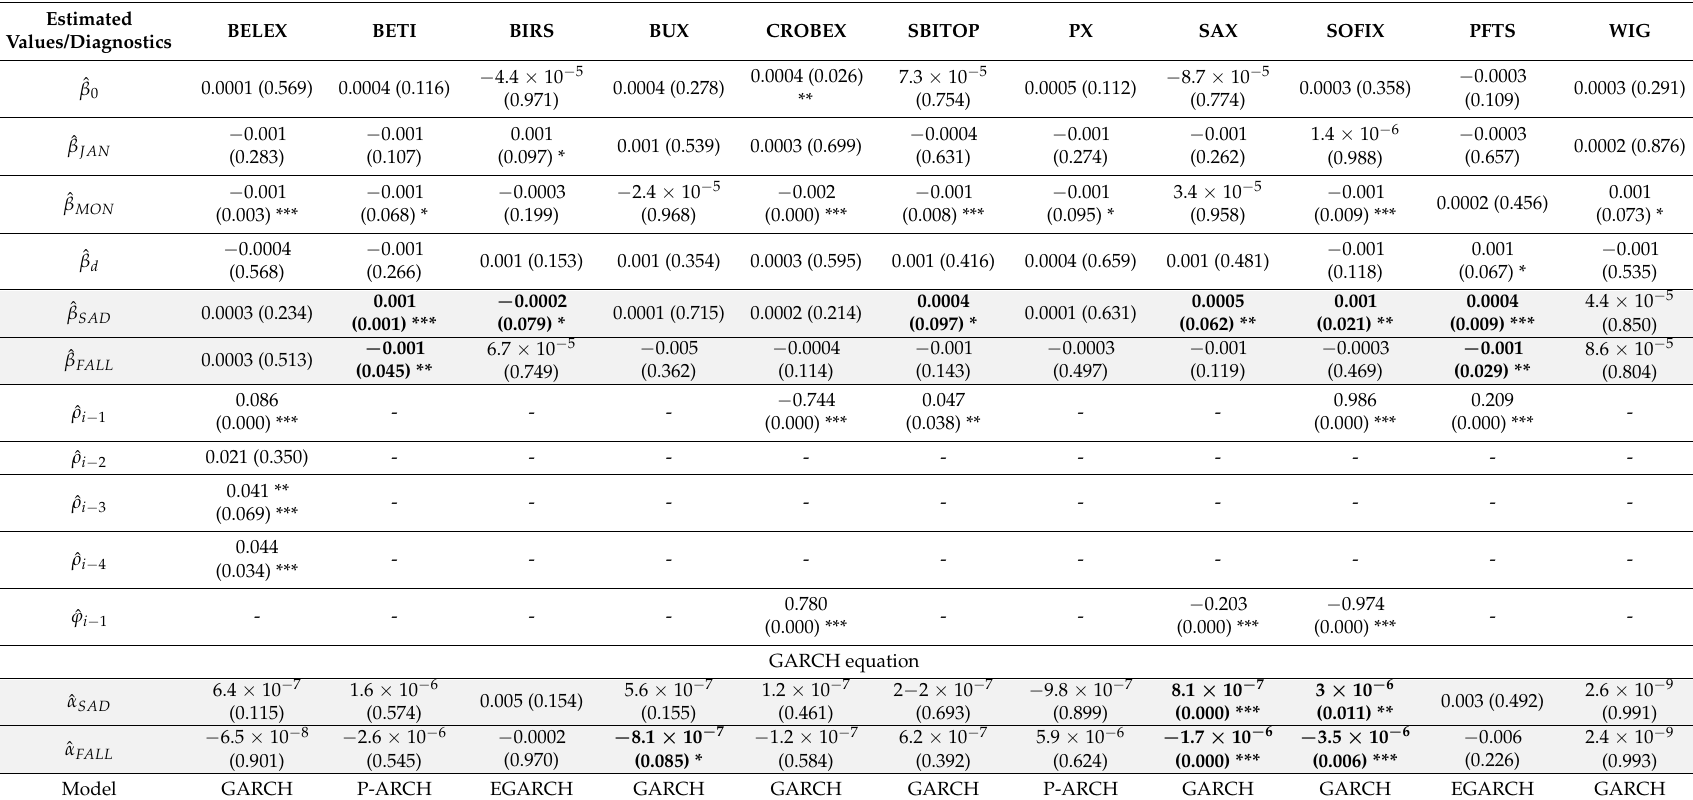
Table 3. Estimation results of model (6) with GARCH